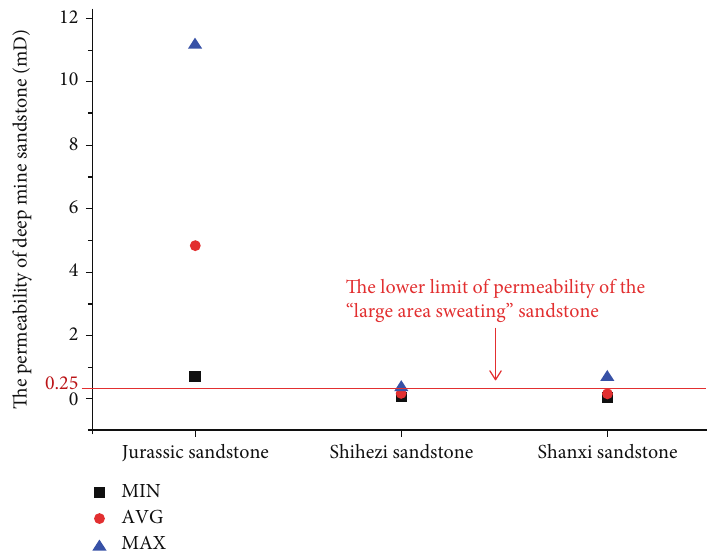
Figure 7: Permeability distributions of the three layers of deep mine